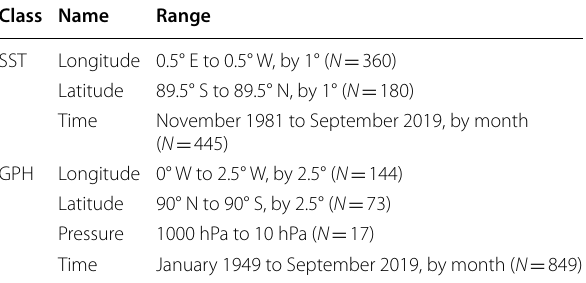
Table 2 Range of the provided sea surface temperature (SST) data and geopotential height (GPH)